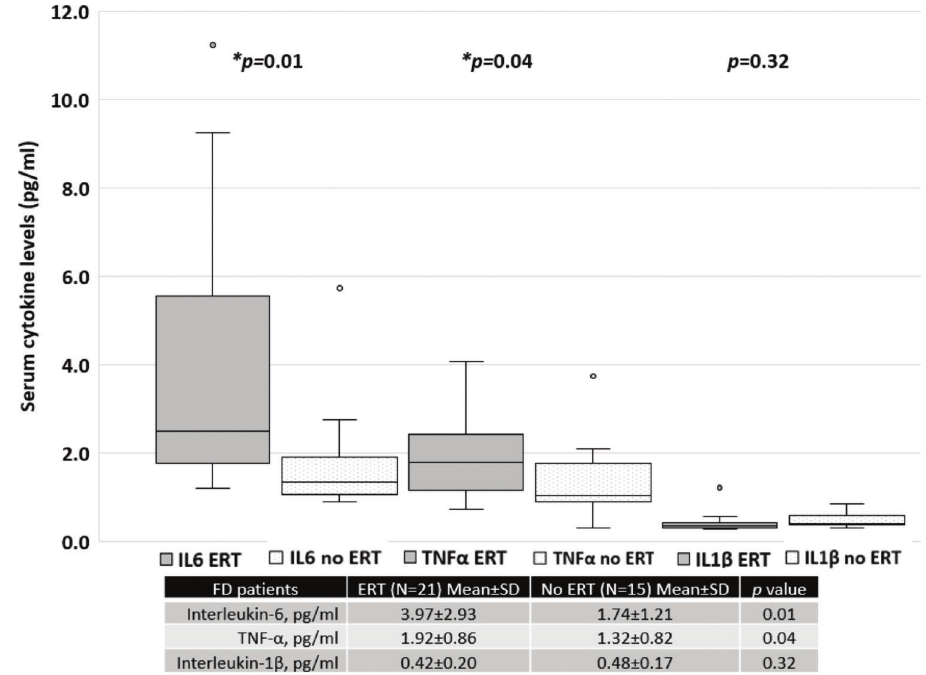
Figure 4 - Serum cytokine levels in FD patients treated with ERT versus those not treated with ERT.